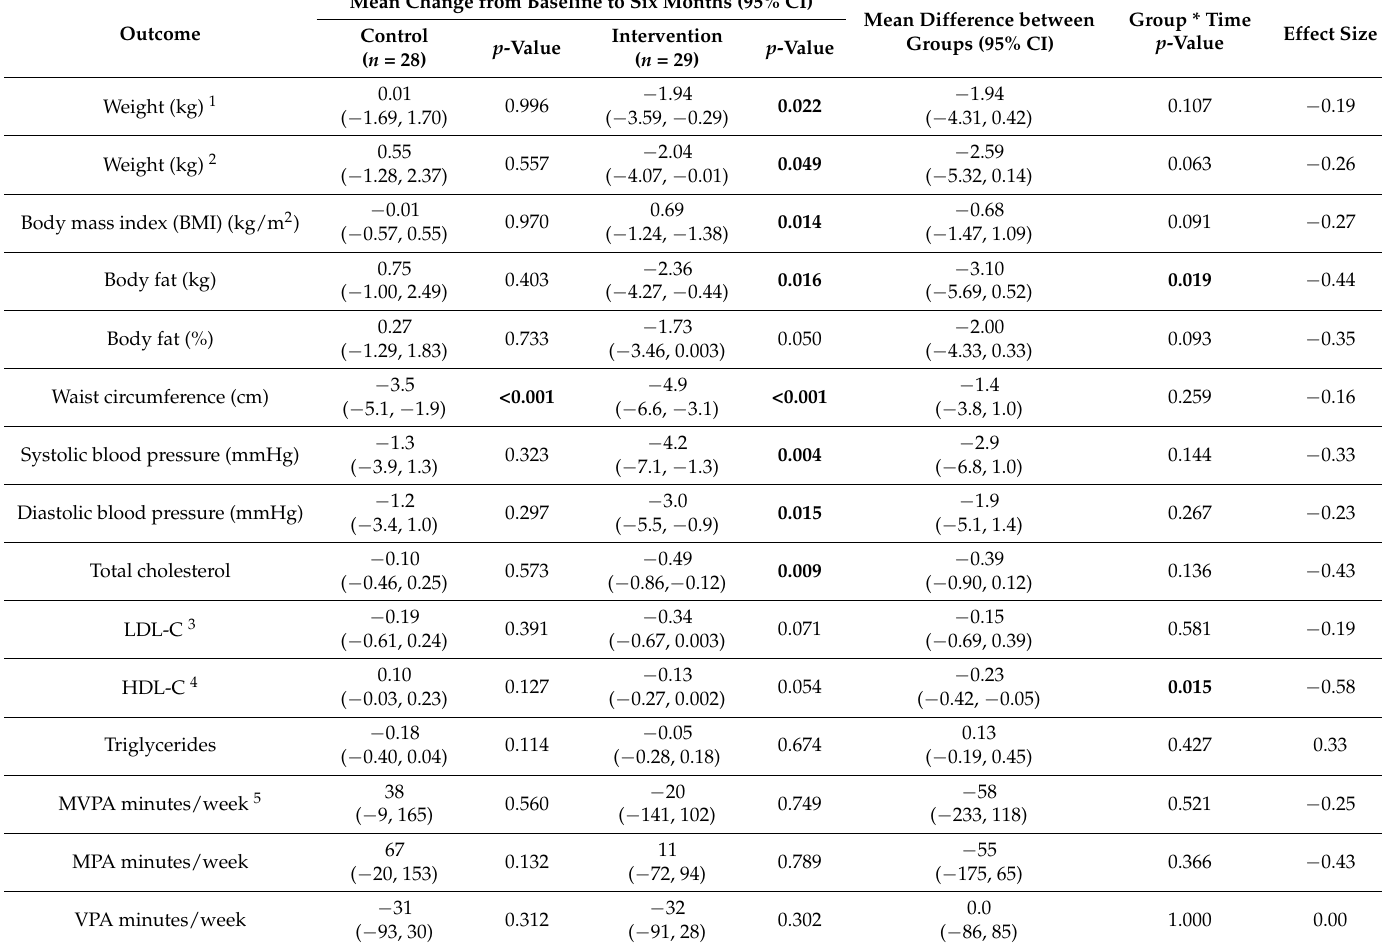
Table 3. Primary and secondary outcome changes in young women ( n = 57) participating in the Be Positive Be Health e six-month weight loss program randomized control trial (RCT) from baseline to 6 months using intention-to-treat (ITT)